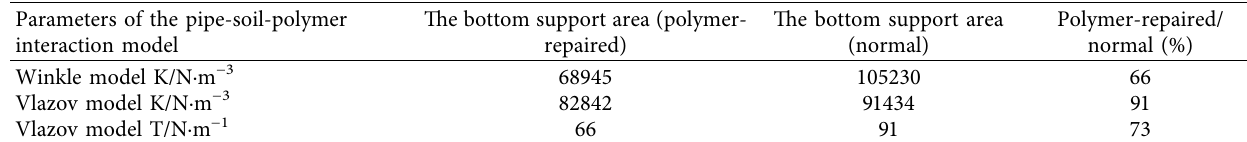
Table 2: Model parameters of the pipe-soil-polymer interaction analysis. Parameters of the pipe-soil-polymer The bottom support area (polymer- The bottom support area interaction model repaired) (normal) normal